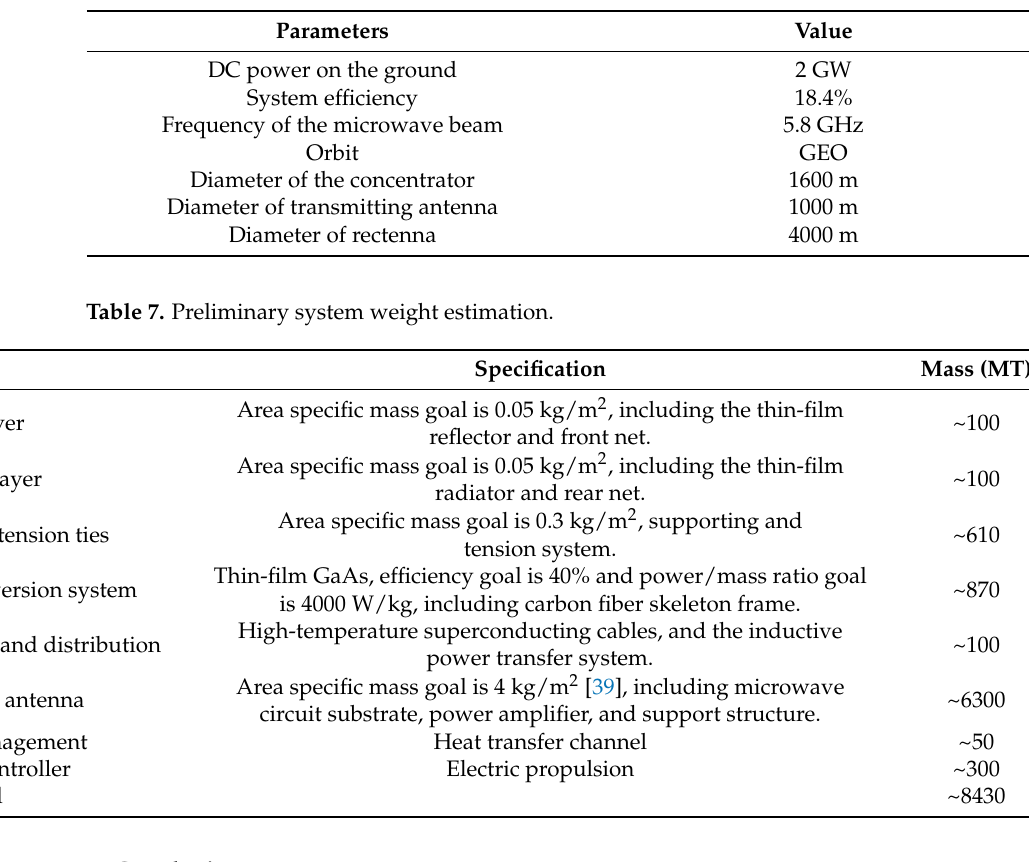
Table 6. The system parameters of the 2 GW-level two-layer ring truss-based SSPS.